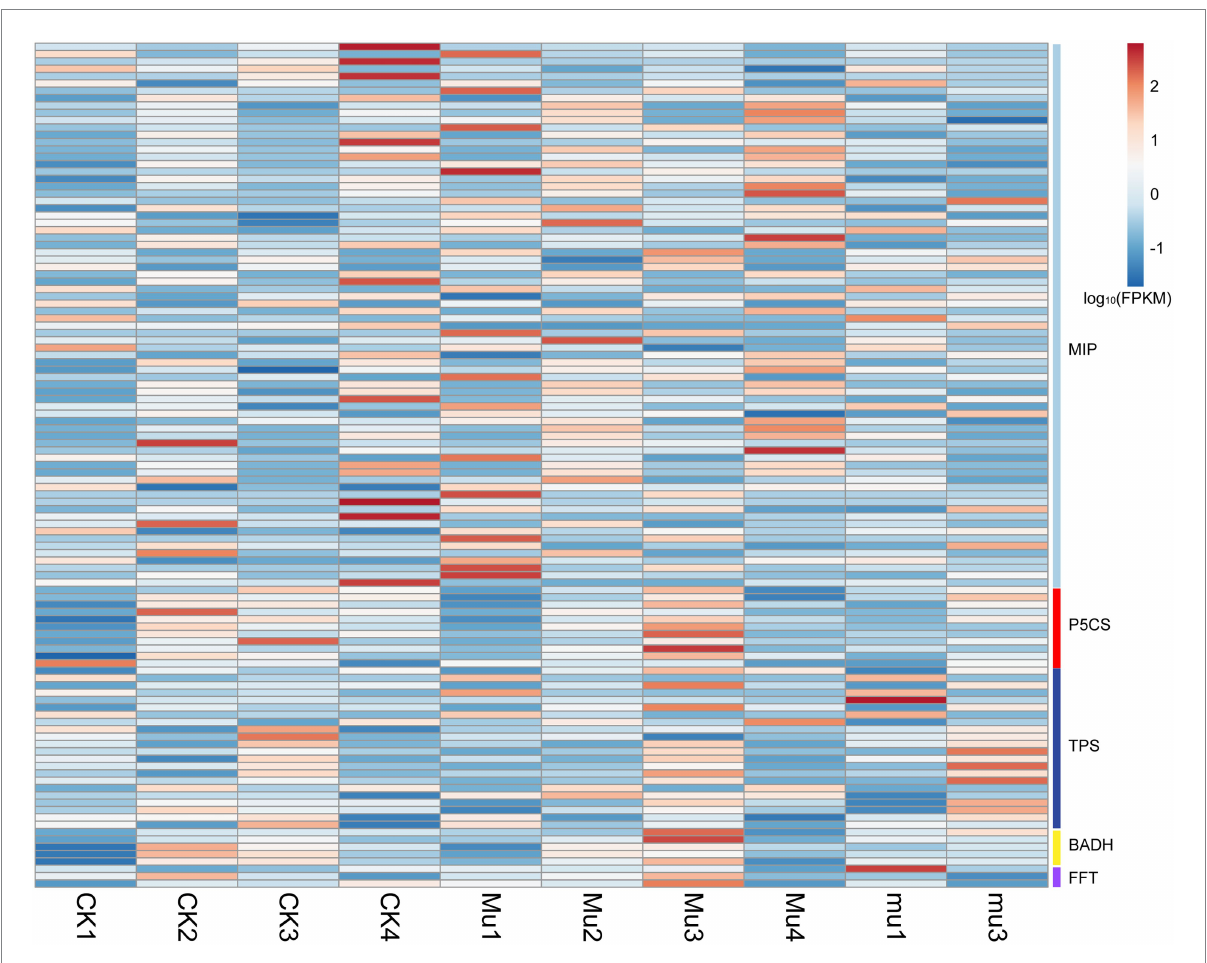
FIGURE 4 Heatmap showing the expression of DEGs related to osmotic regulation. Gene expression is normalized using FPKM and represents the means of three biological replicates. Expression values are presented as FPKM normalized log10-transformed counts. The color represents relative gene expression levels. While the horizontal direction shows the sample names, the vertical direction shows the names of genes involved in osmotic regulation. MIP: major intrinsic protein, P5CS: Delta-1-pyrroline-5-carboxylate synthase, TPS: trehalose-phosphate synthase, BADH: betaine aldehyde dehydrogenase, FFT: fructan